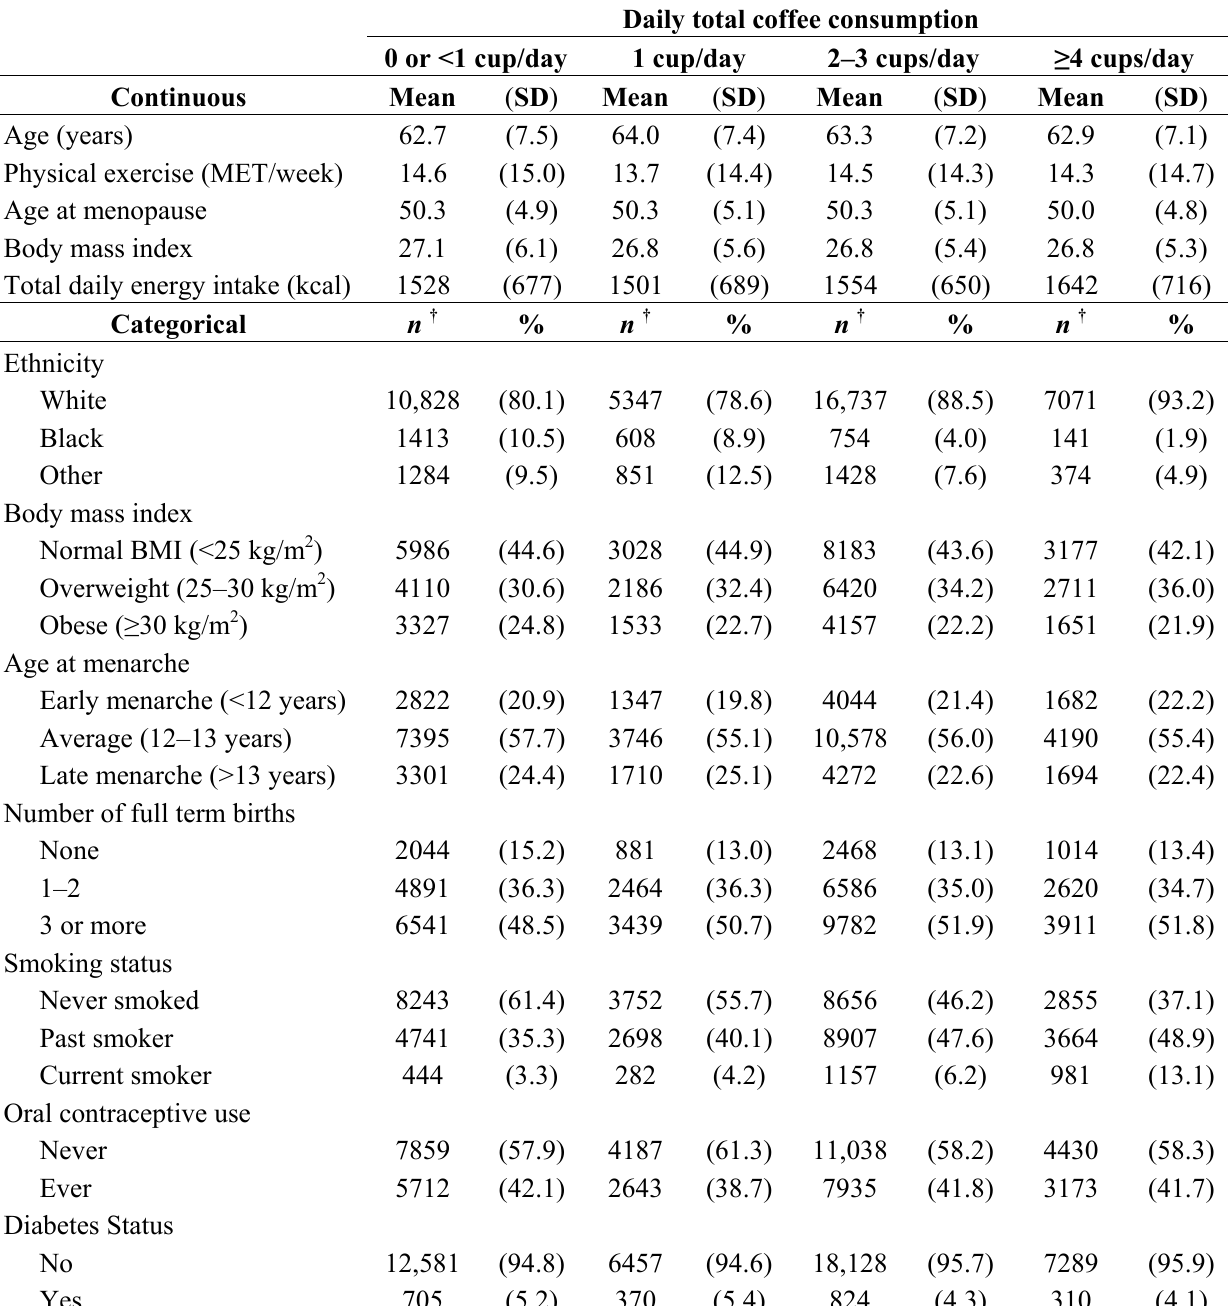
Table 1. Characteristics of study participants at baseline according to coffee consumption in the Women’s Health Initiative Observational Study ( n =